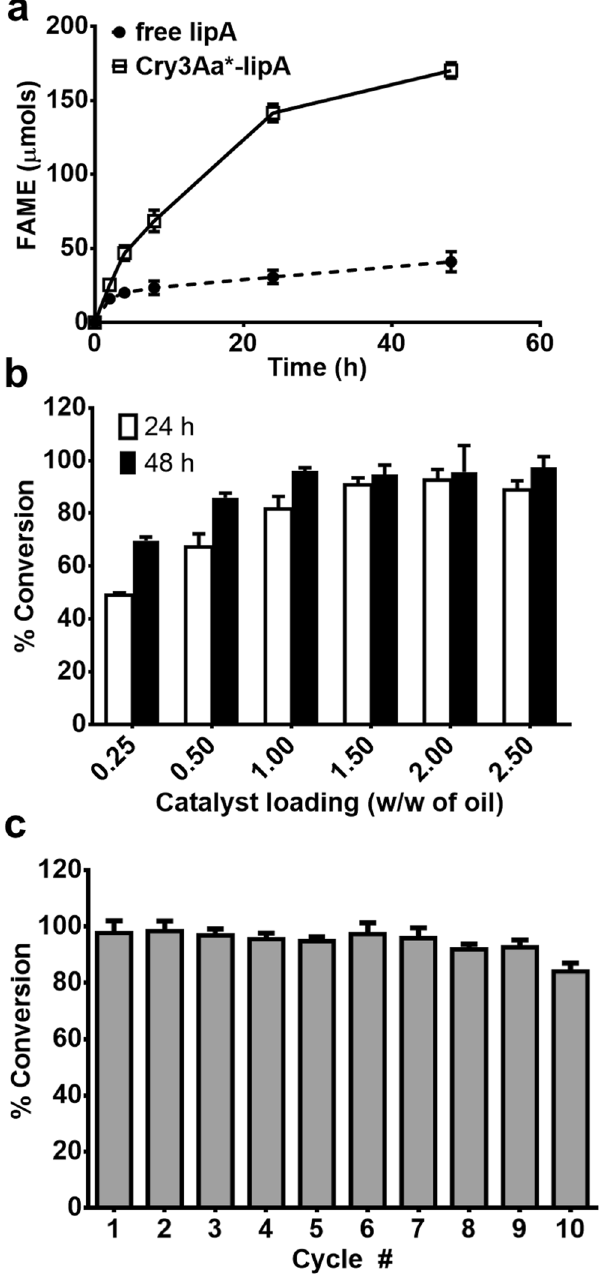
Figure 5. Biodiesel production by Cry3Aa * -lipA crystals. ( a ) A time-point study of the transesterification reaction of coconut oil and MeOH by free lipA and Cry3Aa * -lipA. At 2, 4, 8, 24, and 48 h samples were taken and analyzed by gas chromatography (GC). ( b ) Yield of coconut oil conversion to FAME biodiesel as a function of catalyst loading after 24 h and 48 h. ( c ) Recyclability of Cry3Aa * -lipA during the production of biodiesel from coconut oil using 2.5% (w/w) catalyst. All experiments were performed in triplicate. The error bars show the standard deviation of the